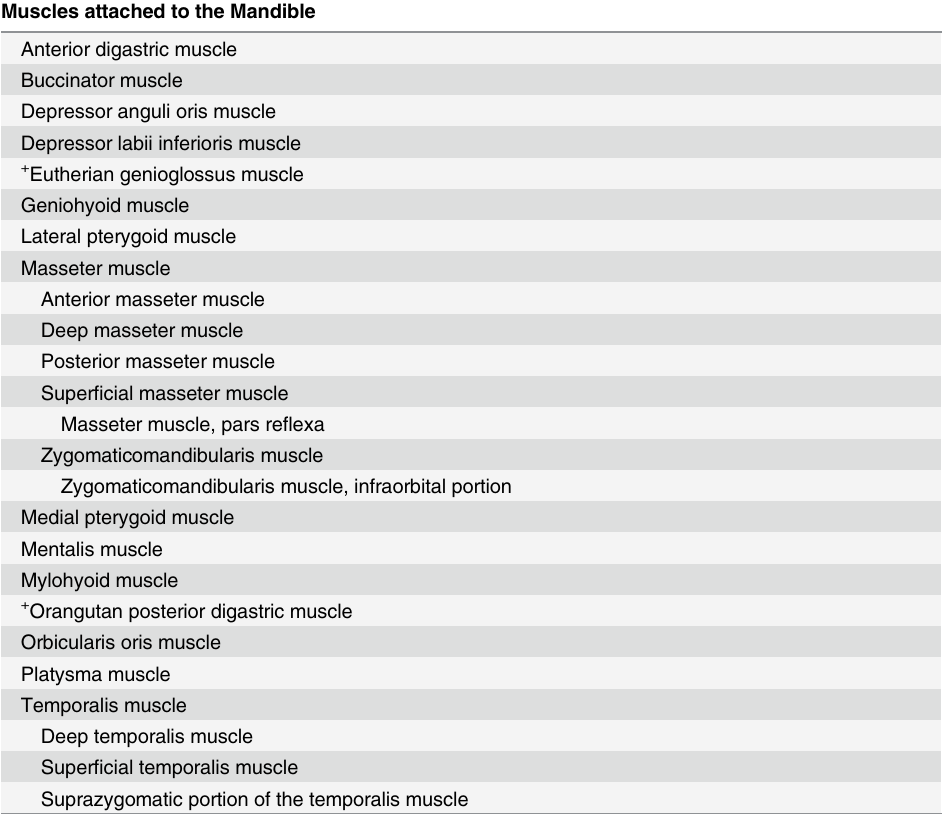
Table 1. Classes returned by the MFMO from a DL Query in Protégé for muscles attached to the mandible. Muscles attached to the